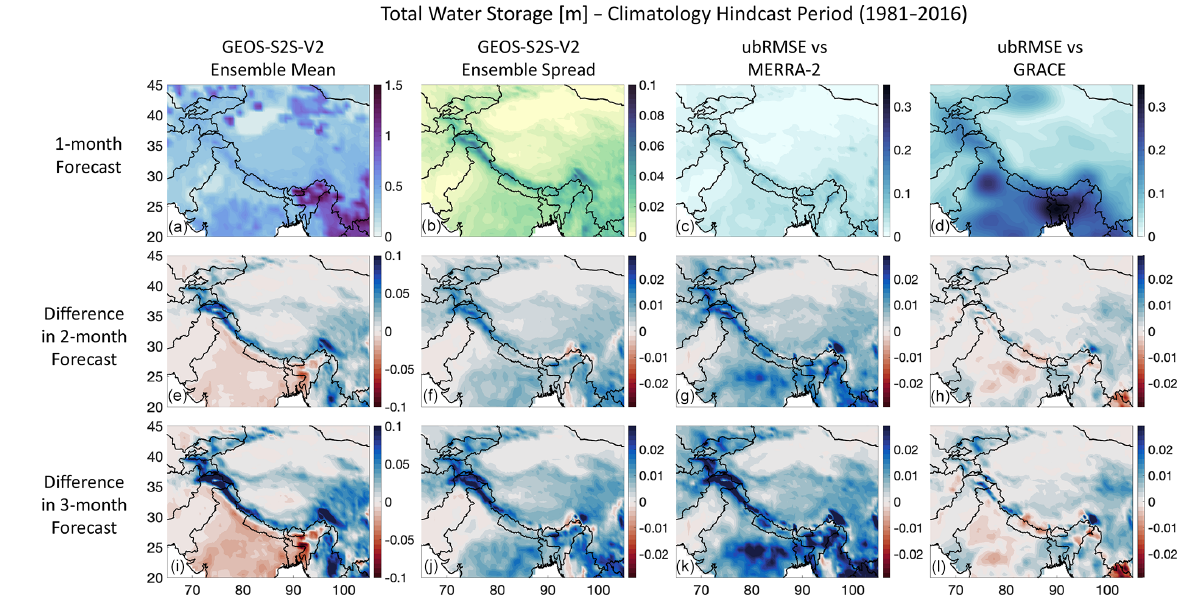
Figure 12. As in Fig. 7, but for terrestrial water storage (TWS) in (m) and vs. GRACE in the right column. Here, red in the subfigures indicates lower values (i.e., less TWS, smaller spread, or smaller error) in the 2- and 3-month forecasts, and blue indicates higher values compared to the 1-month